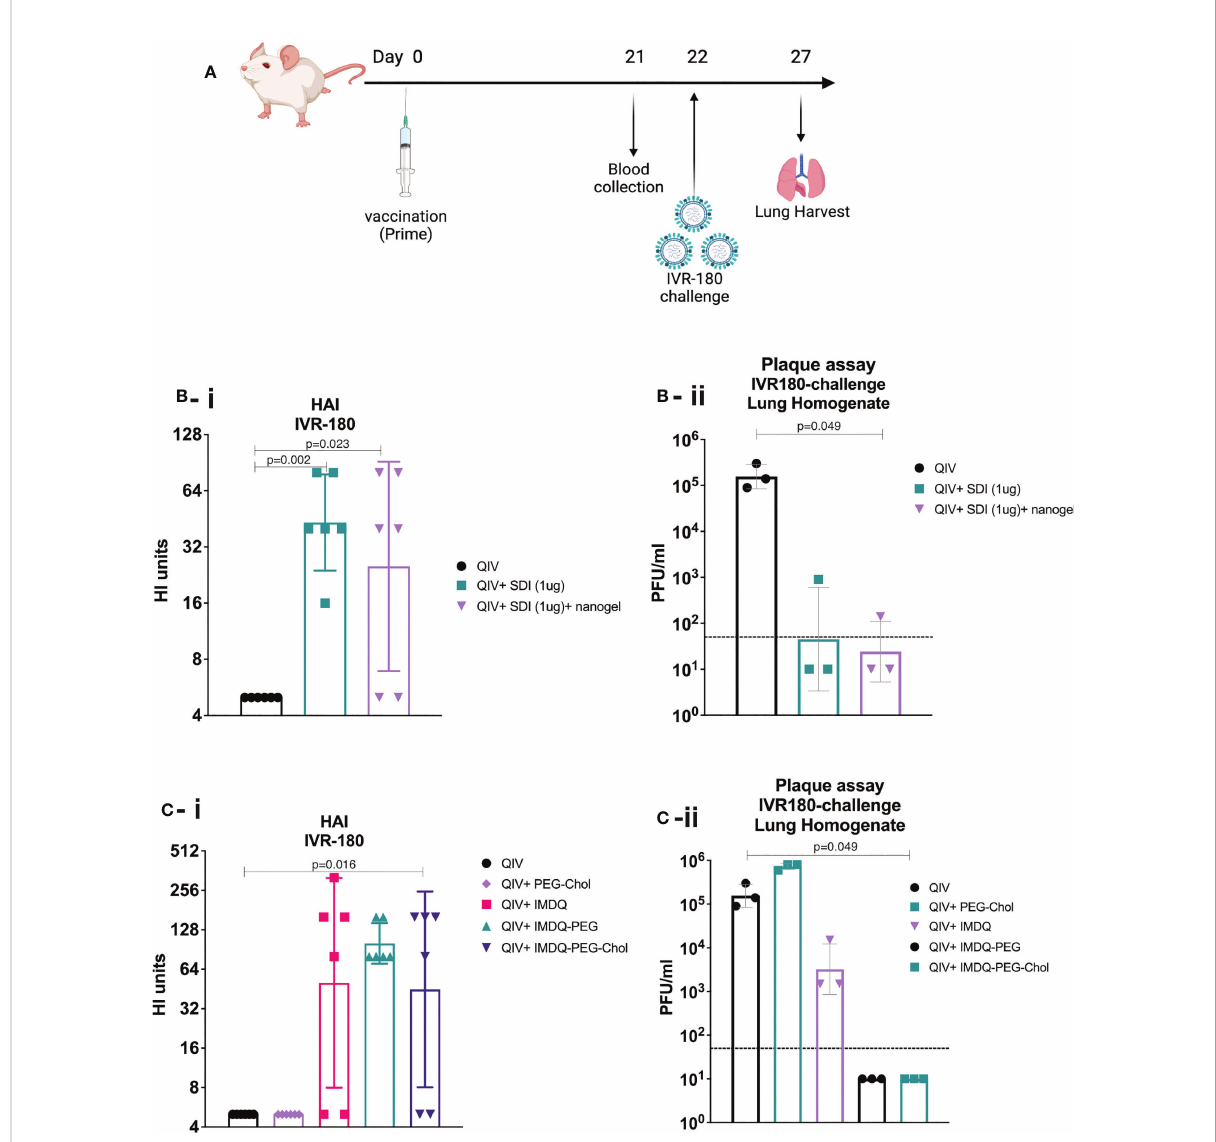
FIGURE 2 SDI+nanogel and IMDQ-PEG-Chol are potent adjuvants for QIV: (A) Schematic representation of the experiment (created with BioRender.com). (A, B) 6-8 weeks BALB/c animals (n=6/group) were vaccinated with unadjuvanted QIV (1.5 m g HA equivalent per mouse) or combined with either 1 m g SDI as adjuvant (with or without 4 m g nanogel) or with 100 m g of different forms of IMDQ. 3 weeks post vaccination, mice sera was examined for HAI titers (B-i , C-i) using 4HA units/well of IVR-180 virus. Consecutively, 3 animals from each group were challenged with 100LD 50 of IVR- 180 virus, and the lung virus titers were quanti fi ed by plaque assays on pre-seeded MDCK cells, fi ve days post infection (B-ii , C-ii) . Each column represents the geometric mean ± geometric SD for respective groups. Statistical analysis was performed using two-sided unpaired T test. P values are calculated in reference to unadjuvanted QIV group for respective